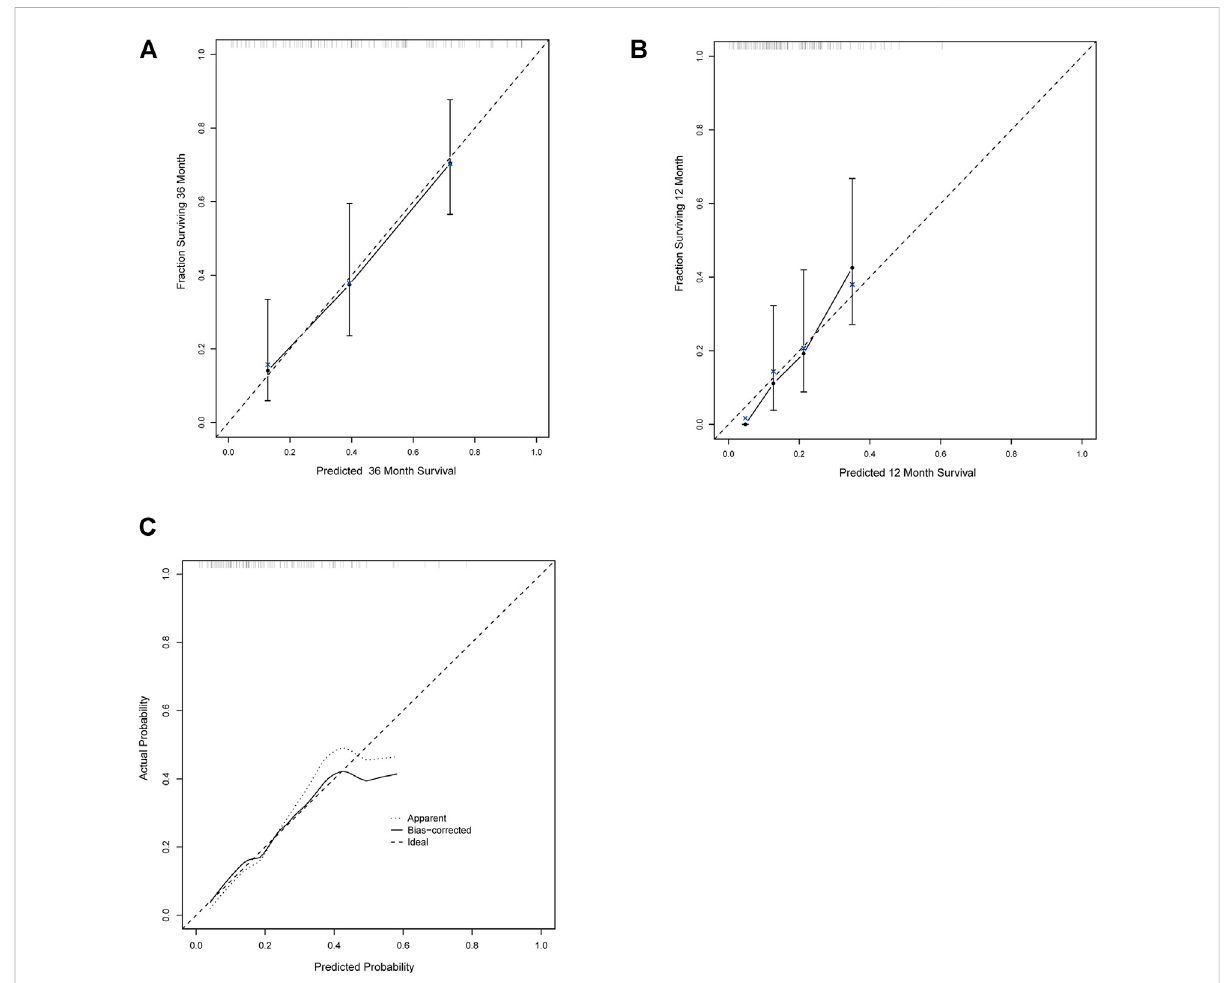
The calibration curves for the probability of OS, PFS, and ORR. (A – C) The calibration curves for the probability of OS (A) , PFS (B) , and ORR (C)